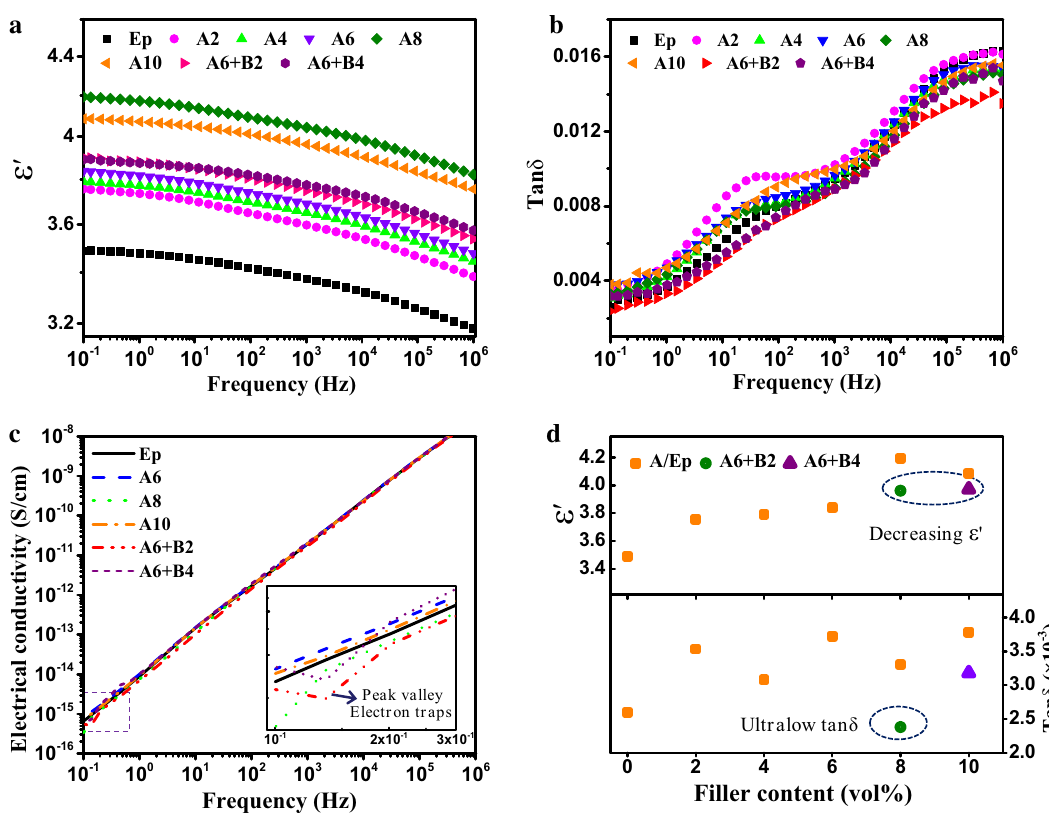
Figure 4. The dependence of ( a ) dielectric constant, ( b ) dielectric loss, ( c ) electrical conductivity of pure epoxy and its composites on frequency. ( d ) Dielectric constant and loss plots of pure epoxy and its